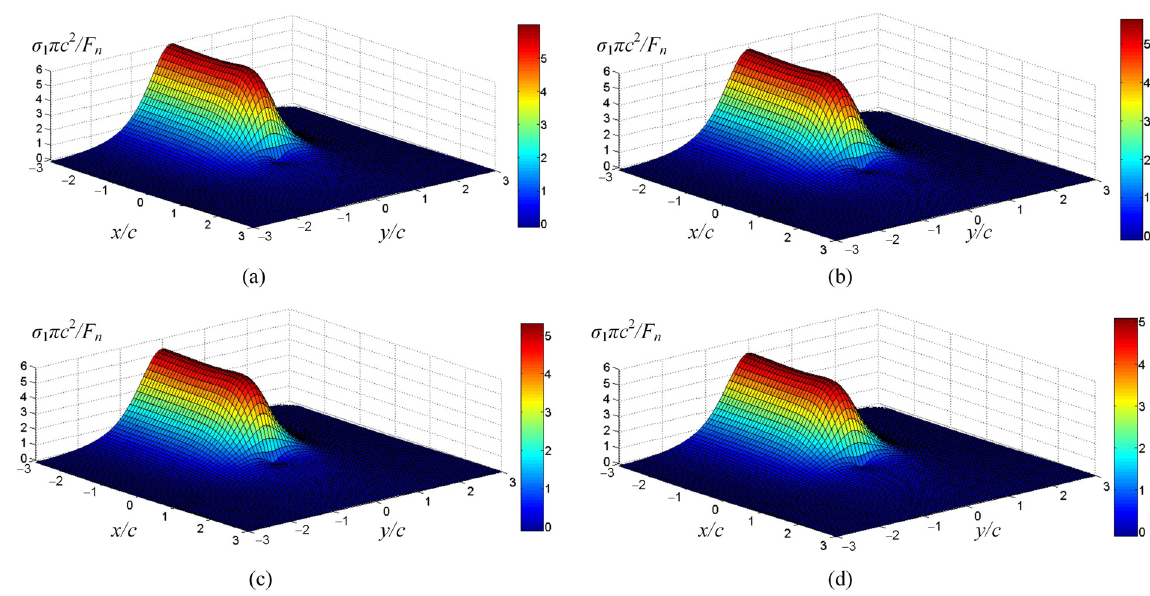
Figure 13. The principal stress distribution around the indenter at different scratch speeds. ( a ) is the scratch speed at 0.1 μ m/s. ( b ) is the scratch speed at 1 μ m/s. ( c ) is the scratch speed at 10 μ m/s. ( d ) is the scratch speed at 50 μ m/s.